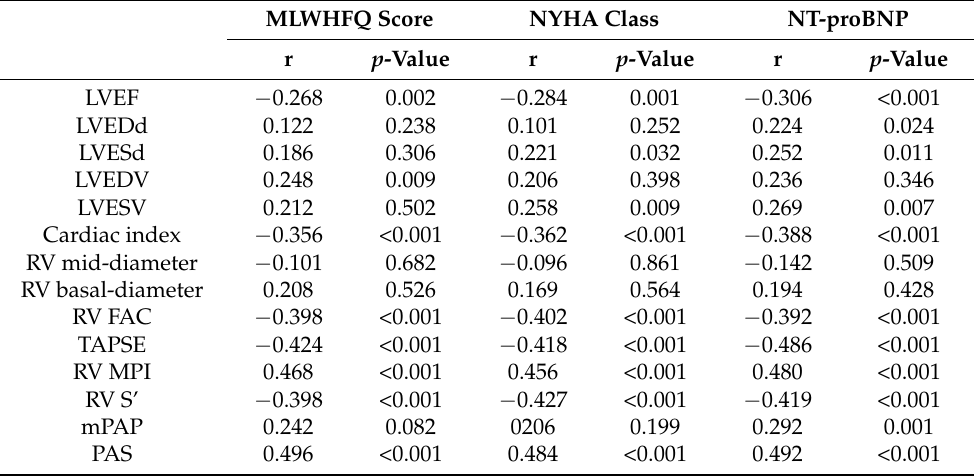
<0.001 <0.001 − 0.392 <0.001 − 0.424 <0.001 − 0.418 <0.001 − 0.486 <0.001 <0.001 <0.001 0.199 0.292 0.001 PAS 0.496 <0.001 0.484 <0.001 0.492